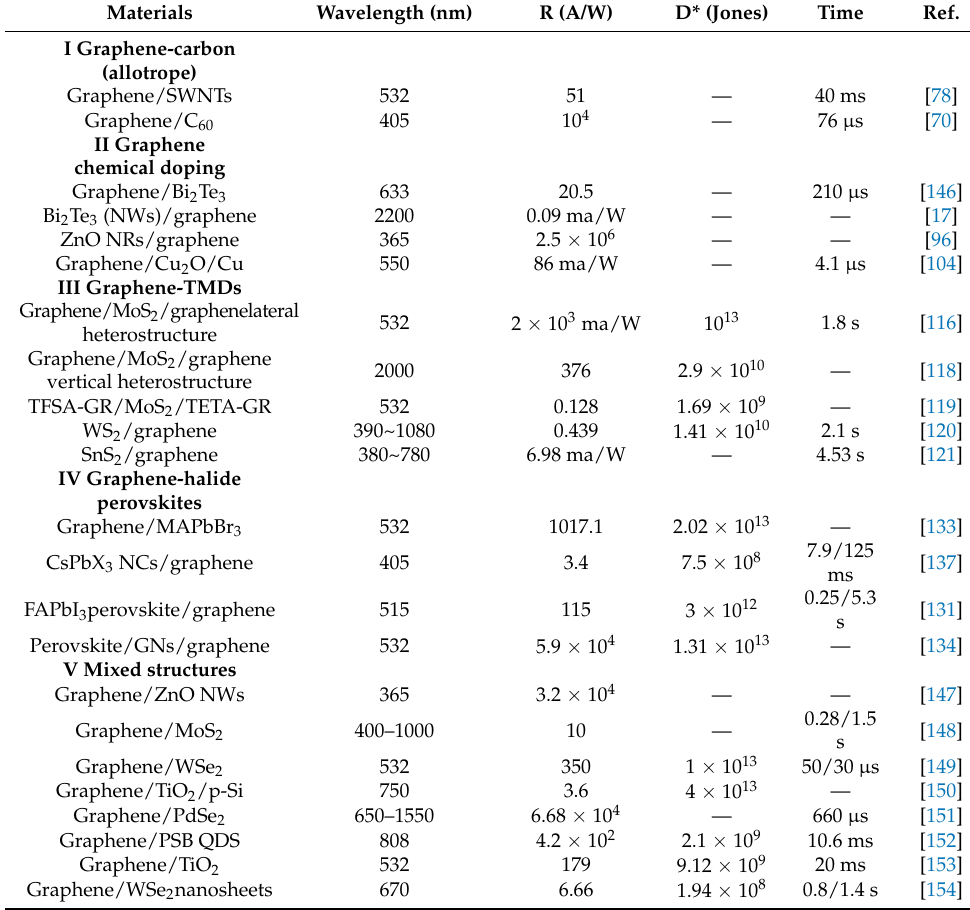
Table 1. Parameters of different